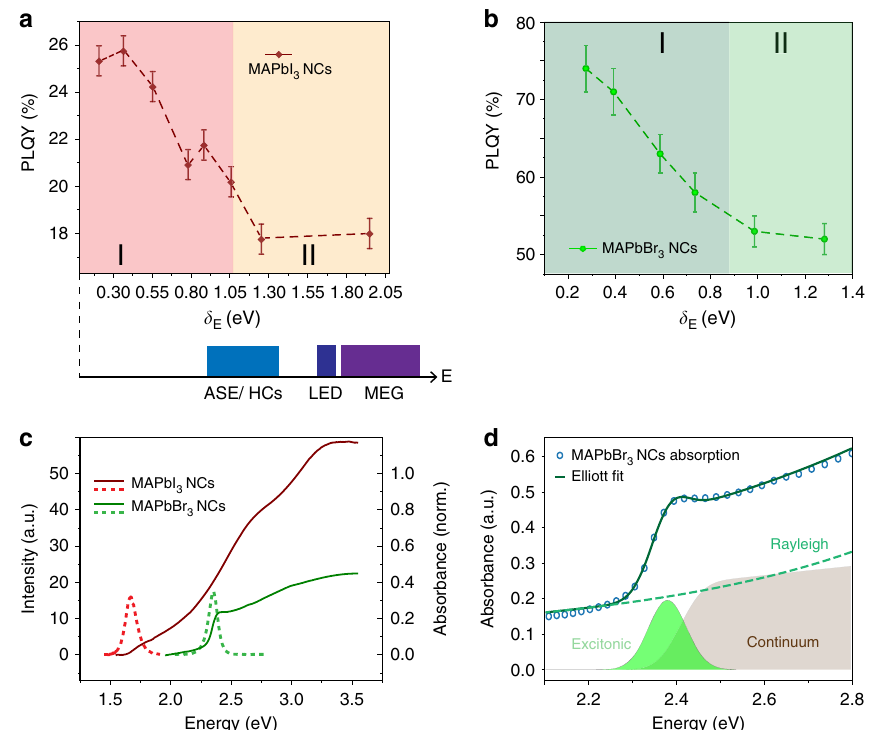
Fig. 1 Steady-state signatures of hot carrier losses. Excitation energy-dependent photoluminescence quantum yield spectra for ( a ) MAPbI 3 and ( b ) MAPbBr 3 NCs, reported as a function of excess excitation energy ( δ E ) with respect to the bandgap obtained from the fi tting the absorption spectra with the Elliott formula (Table 1). Also known as ‘ photo-action spectra ’ . Red squares and green circles represent MAPbI 3 and MAPbBr 3 NCs PLQY values, respectively. Lines are guides for the eye. Error bars represent the standard deviation, estimated through repeated measurements. Excitation energy ranges for potential applications of MAPbI 3 NCs are included below Figure a . c Absorption (solid line) and photoluminescence (dashed line) of MAPbBr 3 and MAPbI 3 NCs in anhydrous toluene solutions. d Fitting of the MAPbBr 3 NCs absorption spectrum with the Elliott formula, deconvolving the contributions due to free carrier absorption continuum (beige region), Rayleigh scattering (green dashes), and excitonic absorption (bright green region).